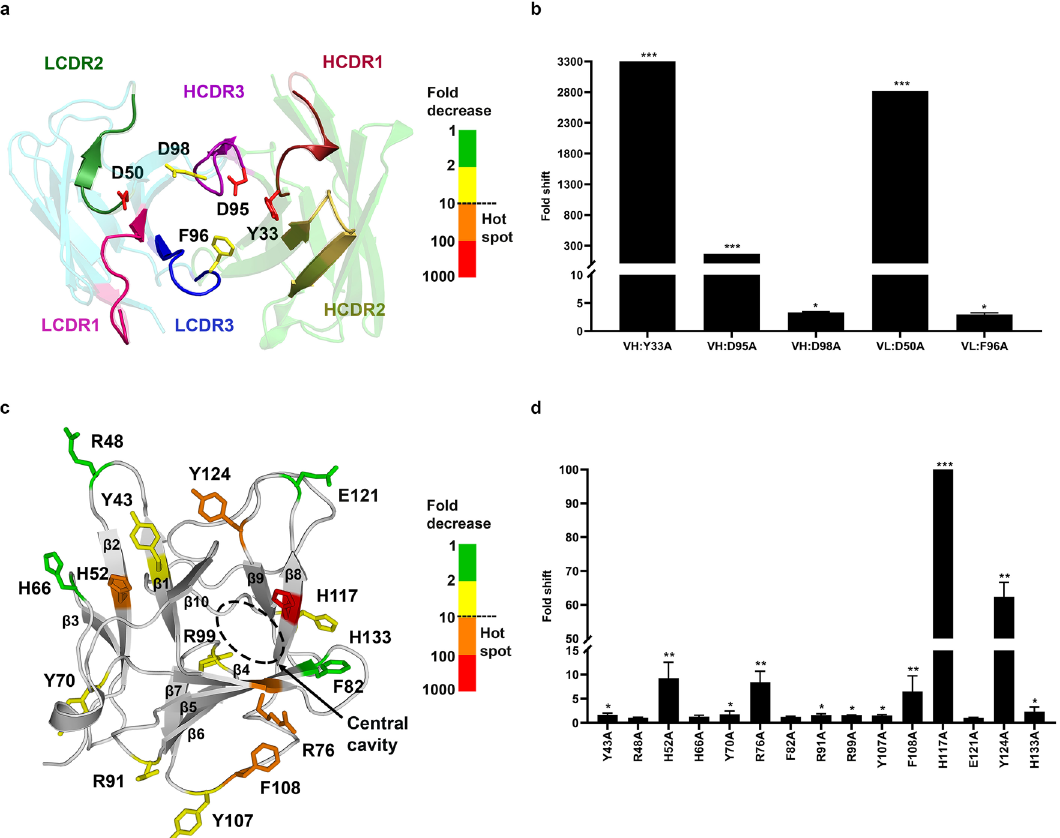
Figure 1. Paratope and epitope scanning for hotspot identification. Fifty-six Burosumab residues that were solvent exposed and covered all CDR loops were mutated to alanine and tested individually for binding to wild- type FGF23 using spot ELISA (Supplementary Tables S2 and S3). For each alanine mutant, the fold decrease in binding was calculated by comparing A450 of each mutant with wild-type Burosumab. The five key affinity altering residue positions (VH:Y33, VH:D95, VH:D98, VL:D50, VL:F96) were identified and mapped onto FGF23-binding interface ( a ). The residue coloring indicates the fold shift in binding relative to WT Burosumab: green: 1–2; yellow: 2–10; orange: 10–100; red: 100–1000. These five positions were considered as constraints for computational docking. ( b ) Fold decrease in binding for a representative set of mutations was shown. Degree of fold decrease was denoted by asterisk (*) as compared to the wild type: 2 to tenfold (*), > 10 to 100 fold (**), and > 100 fold (***). The homology model of Burosumab was built using Rosetta Antibody 3 provided by ROSIE server. CDR numbering was based on Chothia’s definition. For epitope scanning, fifteen solvent-exposed FGF23 residues that covered every domain of N-terminal domain of FGF23 were mutated to alanine and tested for binding to wild-type Burosumab. Fold decrease in binding was calculated from indirect ELISA of FGF23- Burosumab interaction by comparing a K d value (nM) of each mutant with wild-type FGF23. Five epitope residues: H52, R76, F108, H117, Y124 with nearly a 10-fold decrease in binding or more upon alanine mutation were mapped onto FGF23 structures ( c , d ). These key epitope residues appeared to be in close proximity to the D2 and D3 domains of FGF23 receptor (FGFR) (Supplementary Fig. S1). N-terminal domain of FGF23 structure was sourced from PDB ID: 5W21. Structures were illustrated by PyMOL version 2.2.0. The graphs were created by GraphPad Prism version